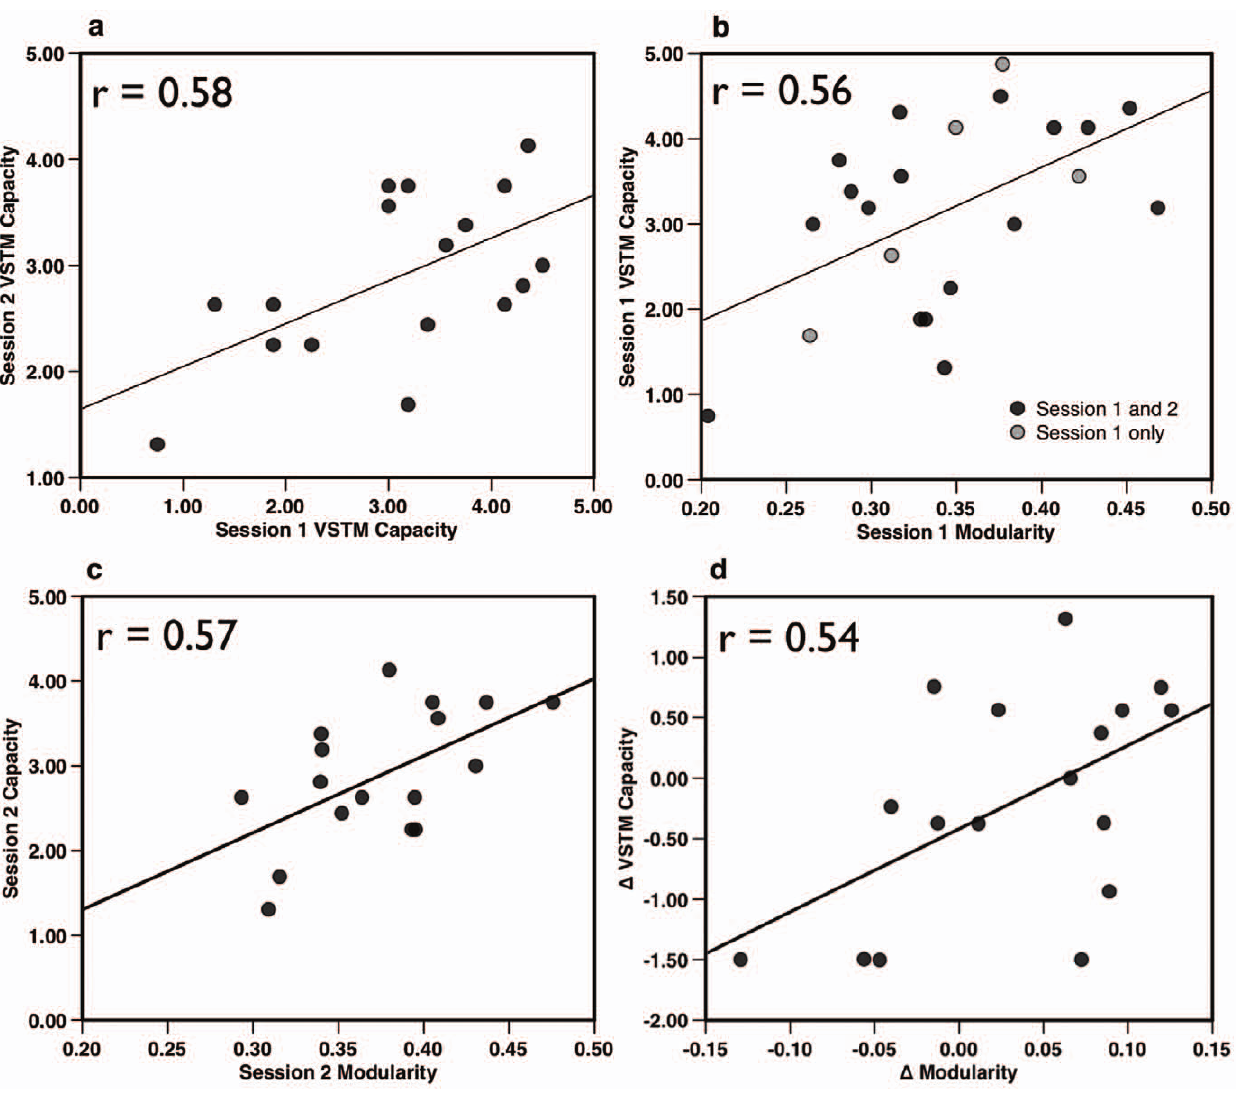
Figure 2. Association of Modularity and Visual short-term memory (VSTM) capacity. VSTM capacity measures were reliably correlated across a ) Sessions 1 and 2 (p=0.014). b ) Modularity and VSTM capacity measured in Session 1 (n=22) were correlated (p=0.009) as well as c ) when measured three weeks later at Session 2 (p=0.017, n=17). d ) Individual participant’s changes in modularity and VSTM capacity between Session 1 and Session 2 were also strongly correlated (p=0.014), indicating that changes in subject’s VSTM capacity were reflected in the change in their network modularity. All tests two-tailed.